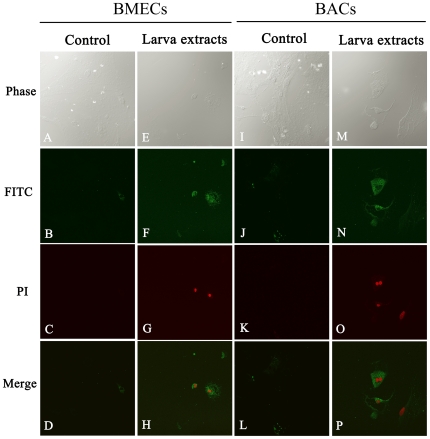
Confocal immunofluorescence images of annexin-V-FITC/PI double staining during in vitro culture with or without A. cantonensis larvae extracts.No positive signal was detected in alone (A–D) cultured BMECs or (I–L) cultured BACs. With larvae extract, however, positive signals were observed in (E–H) BMECs and (M–P) BACs. The same microscopic field was observed by (A, E, I, M) differential interference contrast, (B, E, H and K) FITC channel, and (C, G, K, O) PI channel. This figure shows a representative example of three independent experiments that all gave similar results.